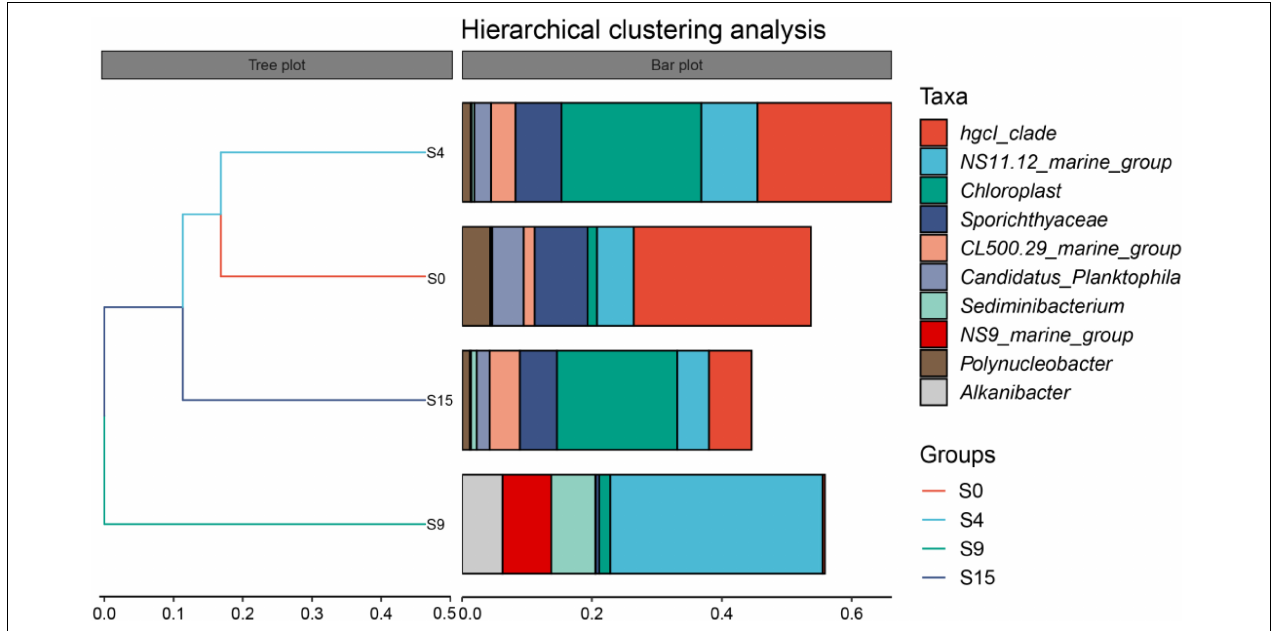
FIGURE 9 | Beta diversity hierarchical clustering